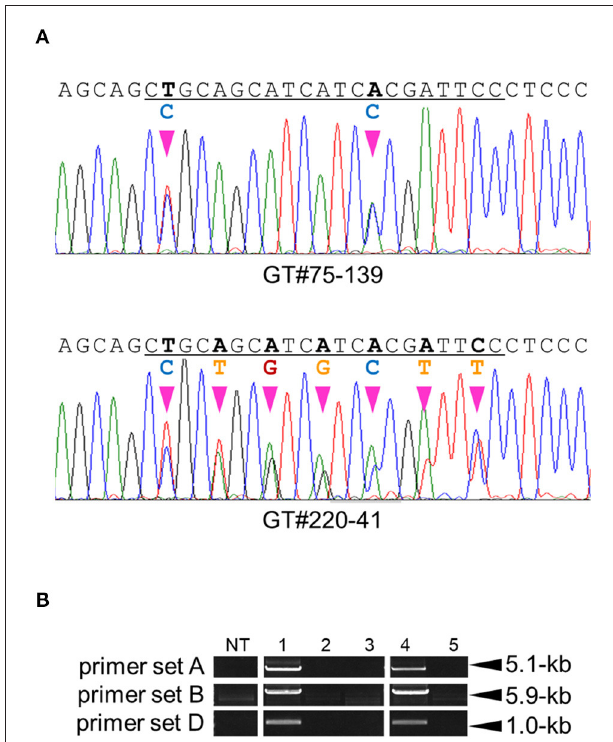
FIGURE 5 | Molecular analysis to confirm GT and marker excision events in GT#75 and 220. (A) Sequencing chromatograms of regenerated plants, GT#75-139 and GT#220-41 derived from GT calli transformed with GT vectors harboring mutations induced by GT-OsCly1 variation 2 and 3, respectively. The miR172 target site region is underlined. (B) PCR analysis to confirm marker excision in GT#75 and GT#220. Samples 1–3: GT regenerated plants (GT#75) transformed with control vector (1), and I- Sce I vector (2, 3). Samples 4, 5: GT regenerated plants (GT#220) transformed with control vector (4), and I- Sce I vector (5). NT; non-transformant. Details as in Figure 3D .